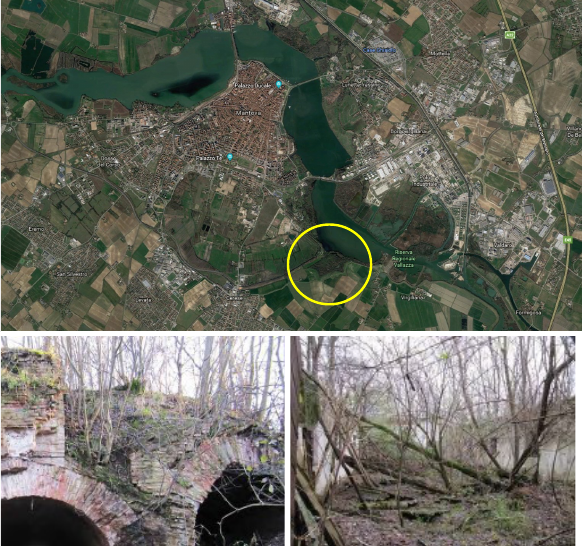
Figure 1. Location of the Fort of Pietole at the south of Mantua (top). State of neglect of the defensive structures and vegetation grow